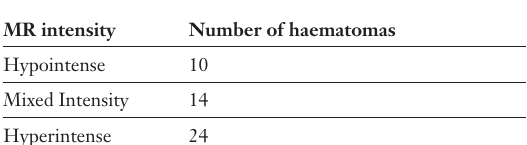
according to MR intensity characteris-